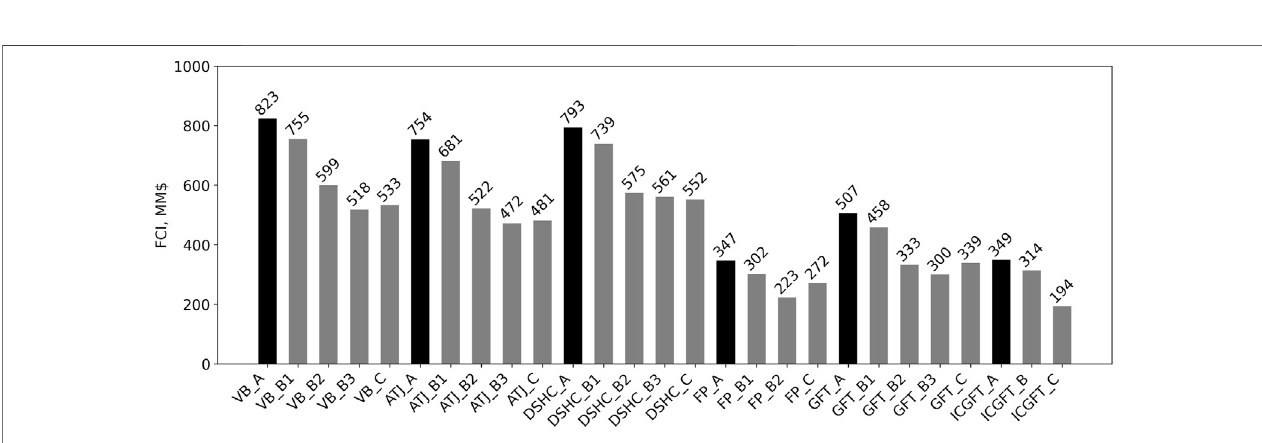
Frontiers in Energy Research |